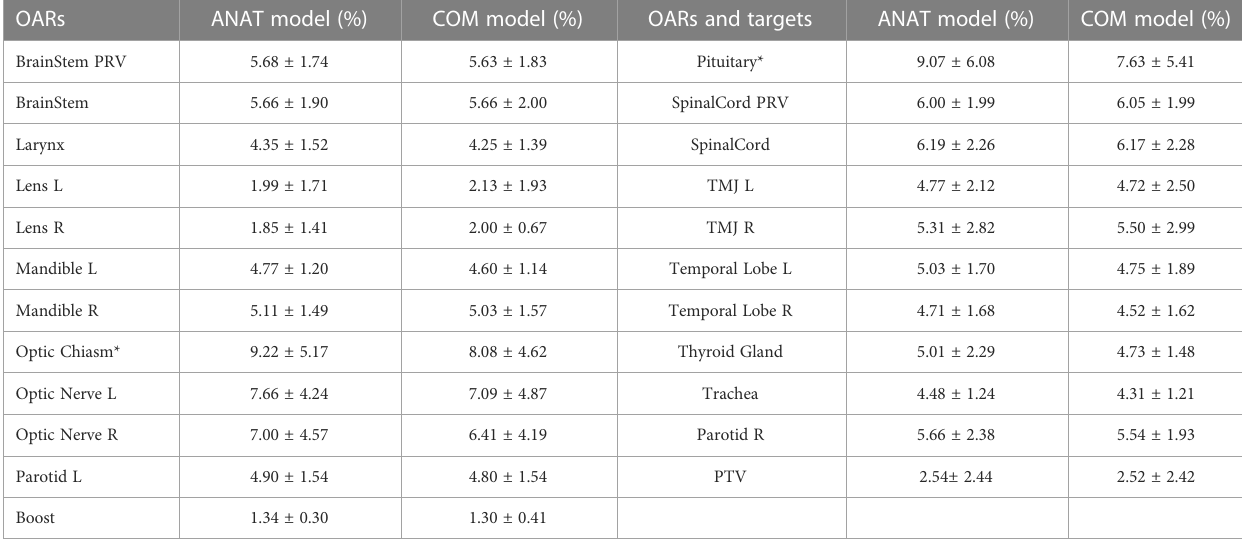
TABLE 1 Comparison of the MAE for each OAR and target.